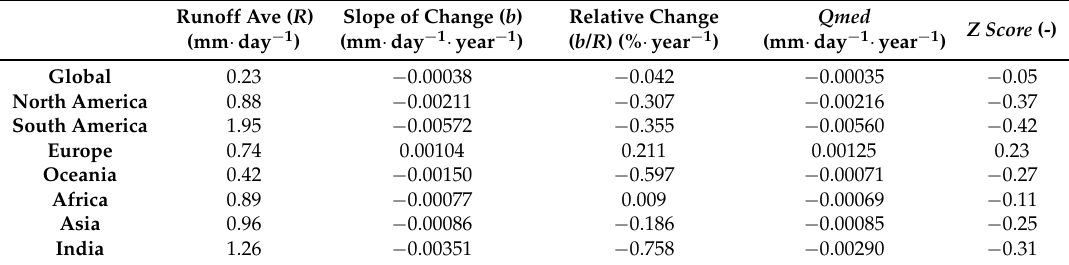
Table 2. Global and continental-averaged trend results of the WBM runoff simulations based on the WFD observation-based inputs, from 1971 to 2001. The Qmed and Z-score indices are obtained from the Sen’s slope estimator and Mann-Kendall methods, respectively, for the runoff.